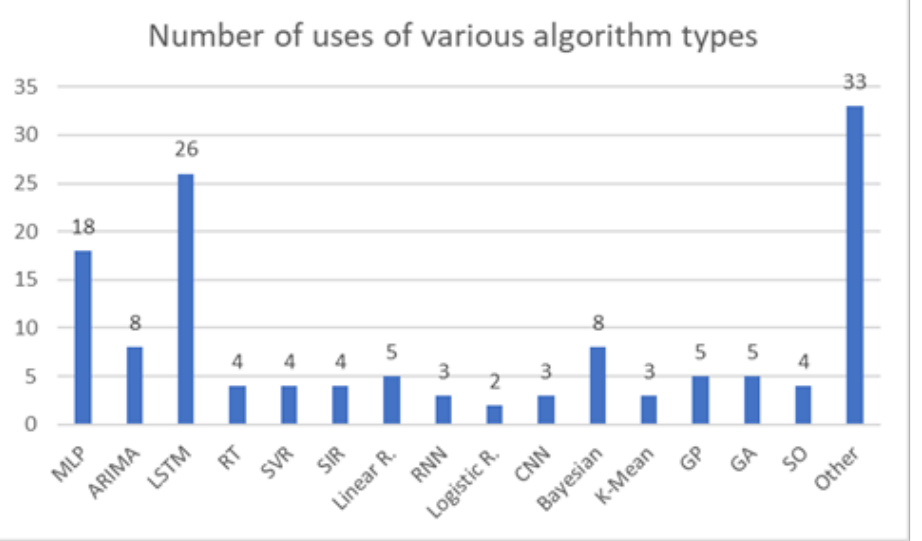
Figure 9. The number of uses of individual algorithms among the reviewed papers. Similar algo- rithms have been grouped. Abbreviation “R” signifies Regression, with other abbreviations given in the text. Single-use algorithms have been grouped into